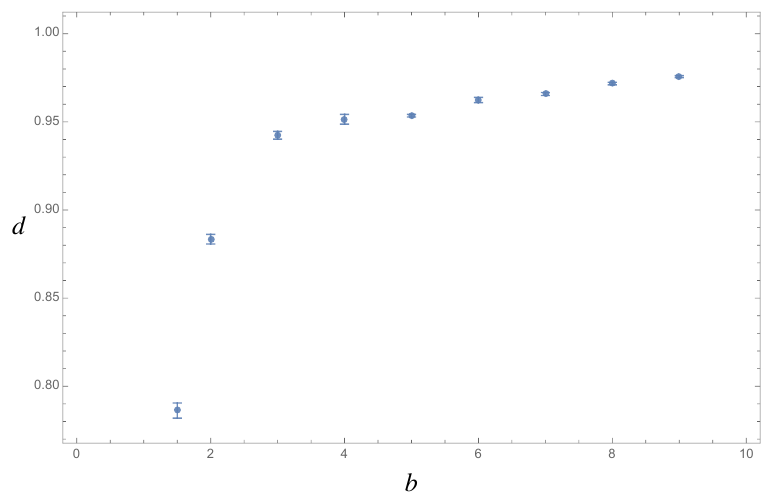
Figure 11 . The B -dependence of the uncertain dimension d . The size of the chaotic region B is defined by | x | ≤ b and | y | ≤ b